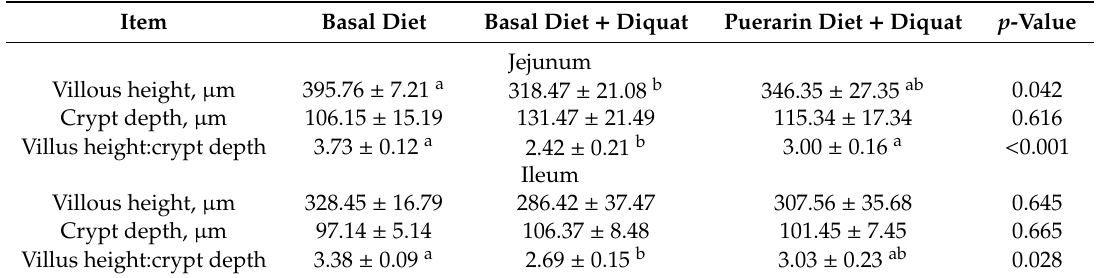
Table 3. E ff ects of dietary puerarin supplementation on jejunal and ileal morphology in the piglets. Item